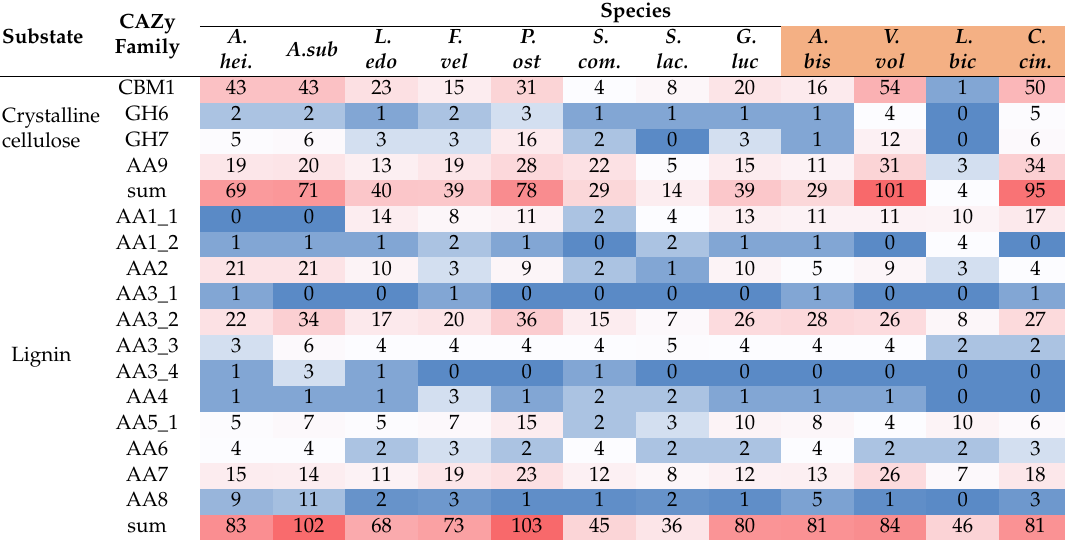
Table 3. Genes numbers of CAZyme families involved in the wood degradation of A. heimuer.